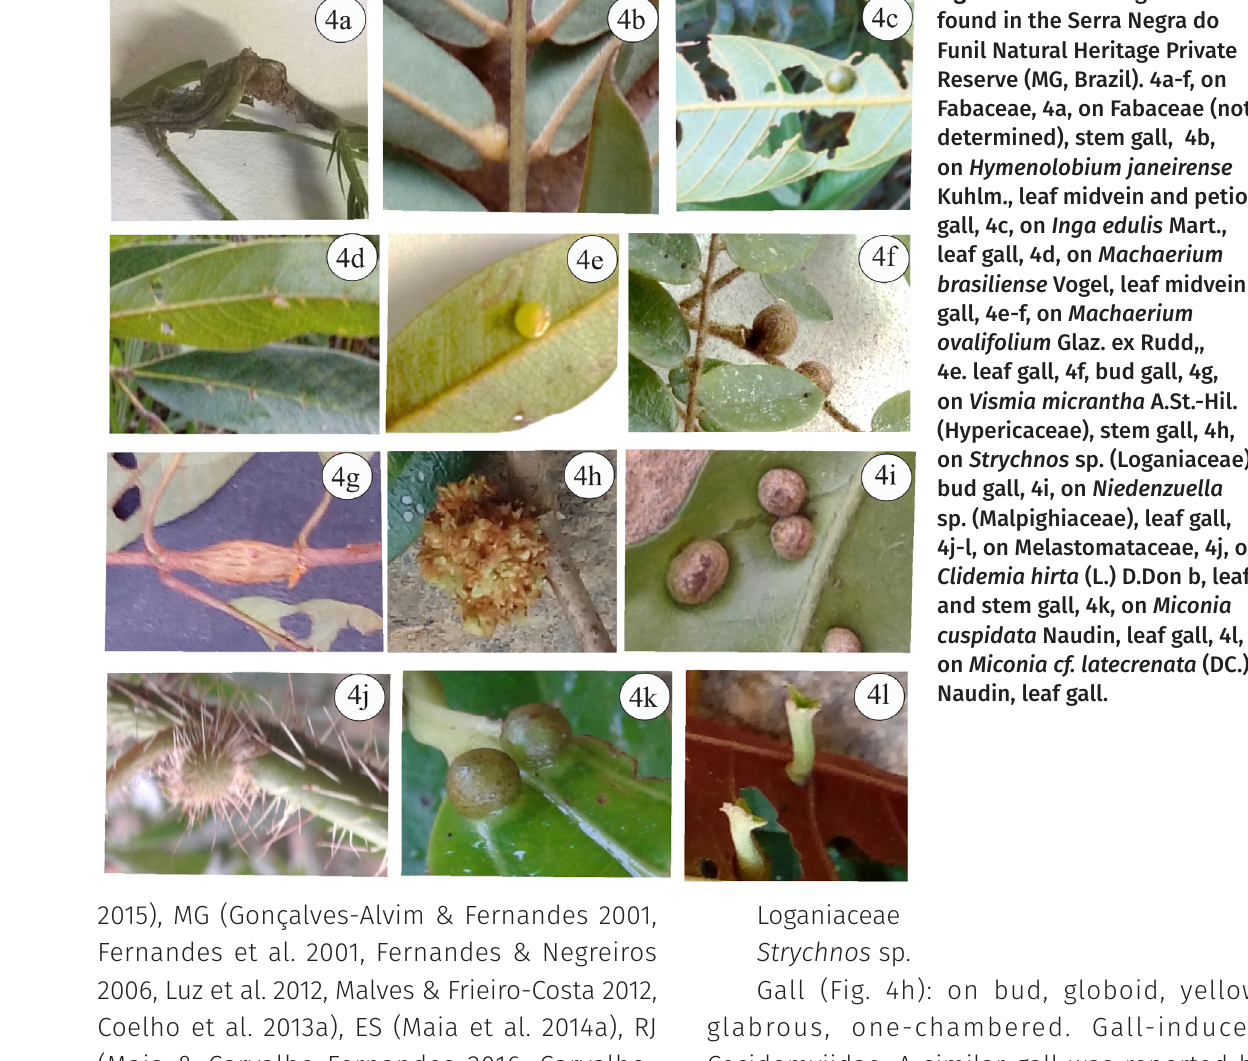
Figure 4. a-l. Insect galls found in the Serra Negra